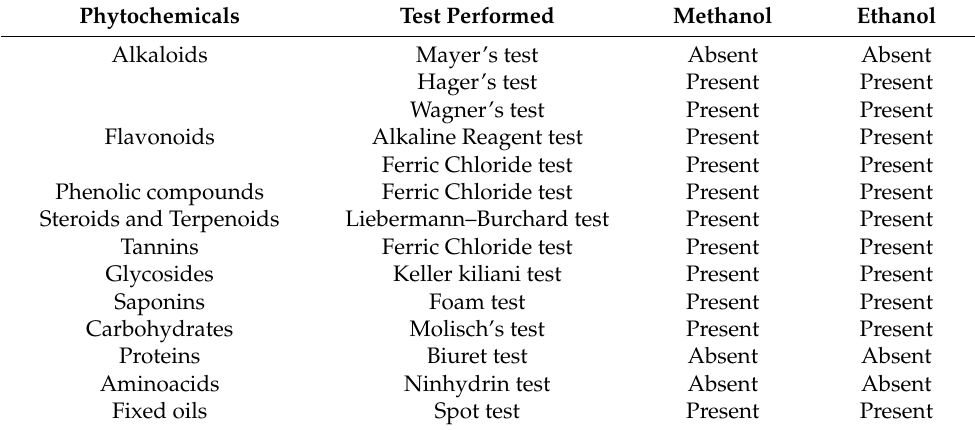
Table 1. Phytochemical screening of leaf extract of Simarouba glauca .